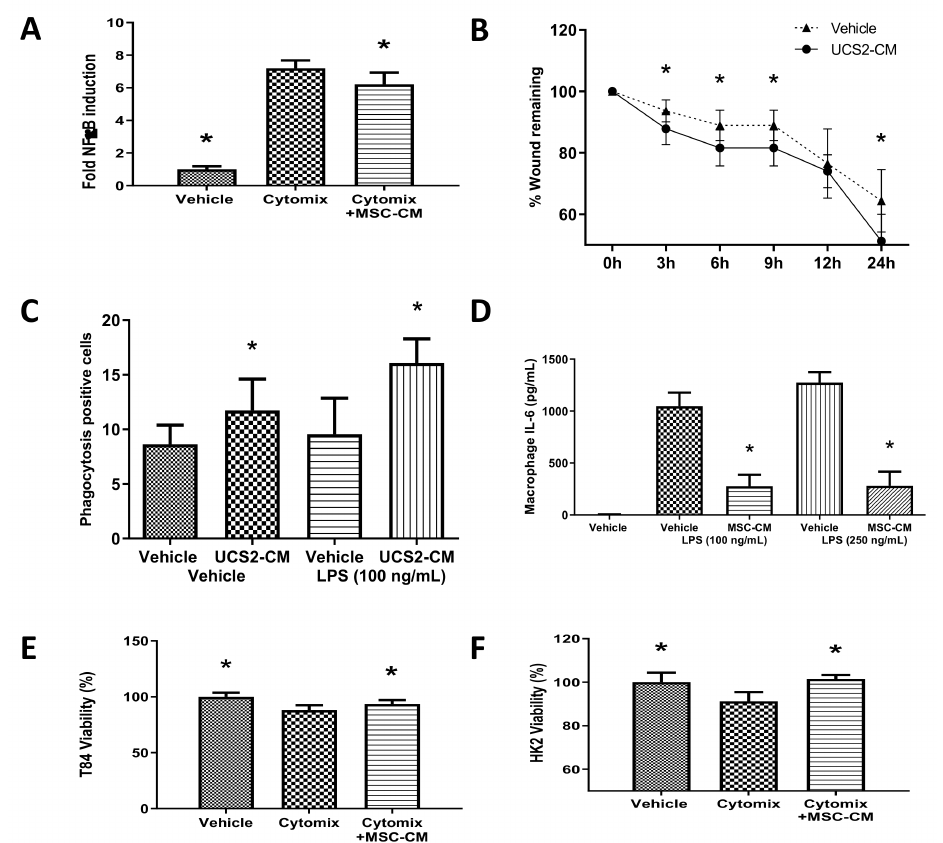
Figure 1. Anti-inflammatory capacity of CD362 + umbilical cord mesenchymal stromal cells conditioned medium (UC-MSC-CM) in vitro. CD362 + UC-MSC-CM decreased interleukin 1 β (IL-1 β )-induced activation of the nuclear factor kappa B (NF- κ B) pathway ( A ) and enhanced wound closure ( B ) in pulmonary epithelial cells. CD362 + UC-MSC-CM increased the rate of phagocytosis in THP-1 macrophages ( C ) and reduced the production of IL-6 in peritoneal macrophages in response to lipopolysaccharide (LPS) ( D ). In other sepsis-relevant tissue cells, CD362 + UC-MSC-CM improved viability in kidney-derived HK2 ( E ) and gut-endothelial-derived T84 cells ( F ) after cytomix-induced injury. * Statistically significant ( p < 0.05) with respect to cytomix group. CD362 + UC-MSCs reduce IL-6 peritoneal macrophage production after LPS stimulation ( D ). * Statistically significant ( p < 0.05) with respect to cytomix ( A , E , F ), vehicle at ( B ) or vehicle at same LPS concentration ( C , D ). Columns represent mean ( n = 6), error bars represent